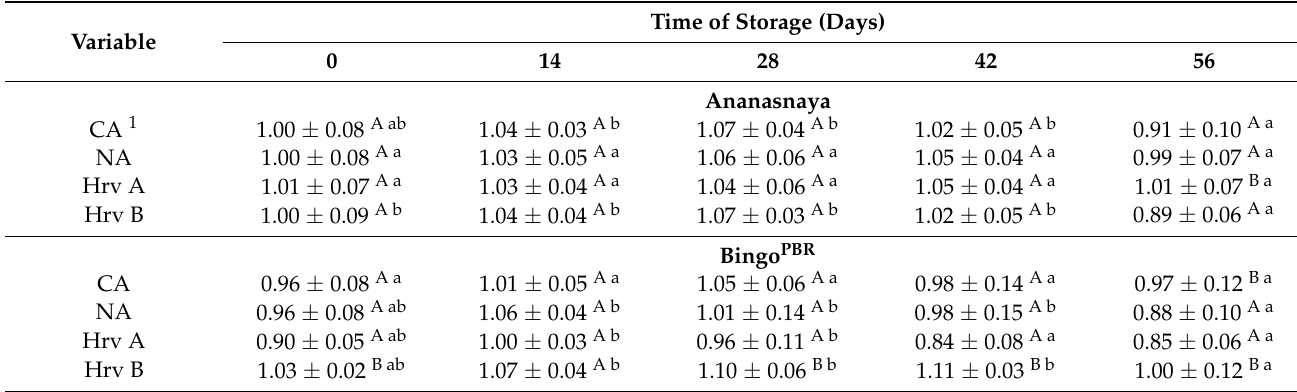
Table 10. Changes of antioxidant activity [mg AAE · 100 g − 1 f.w.] measured in ‘Ananasnaya’ and ‘Bingo’ PBR minikiwi fruit in postharvest